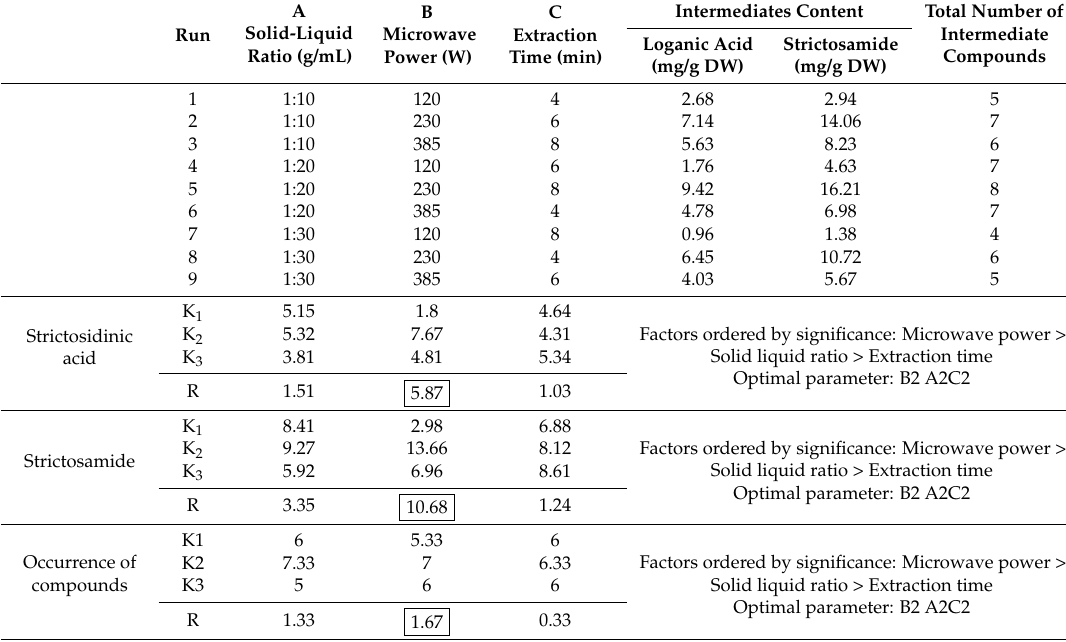
Table 1. The Taguchi L 9 (3 4 ) orthogonal array in terms of multiple factors at three levels and their effects on extraction efficiency of